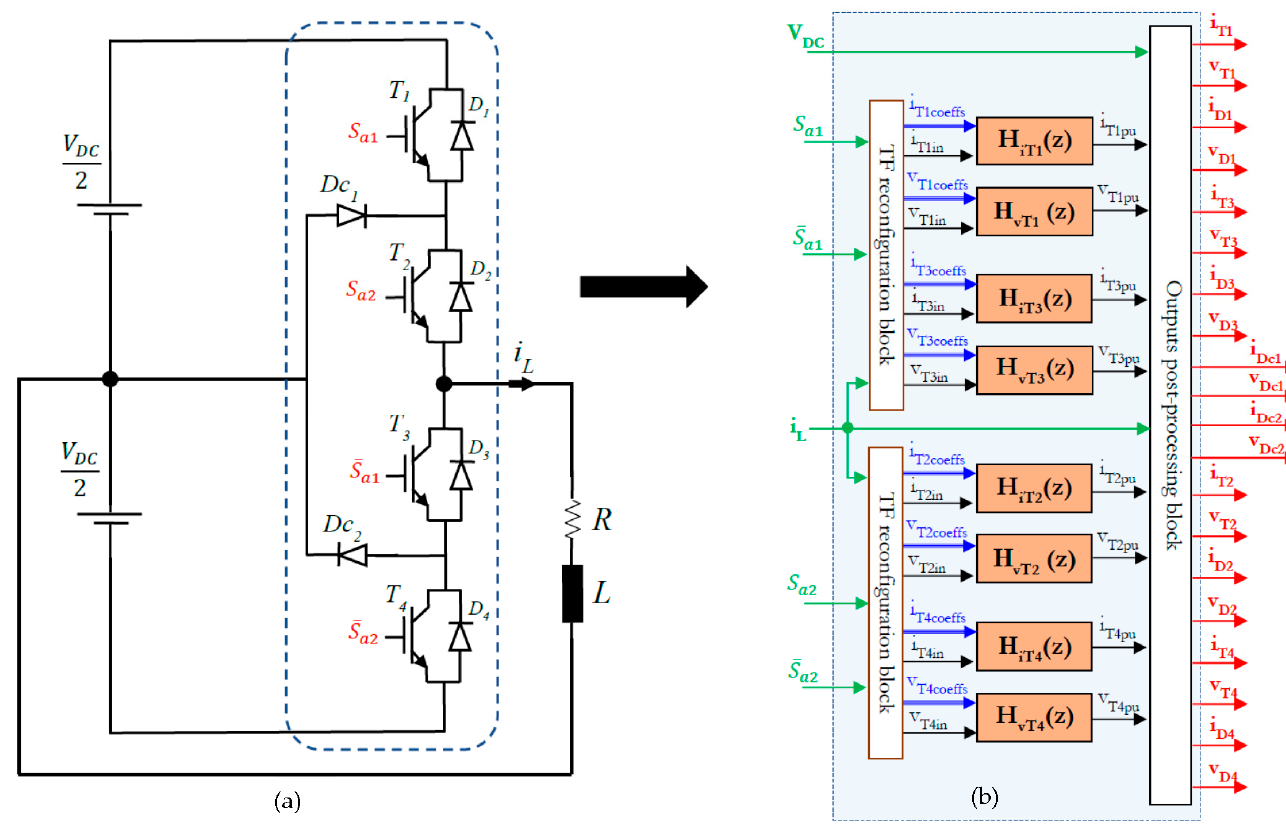
Figure 8. eRTS Half-Bridge NPC inverter. ( a ) topology, ( b ) corresponding eRTS architecture. An open-loop controller id implemented for this case study. A sinusoidal voltage reference od applied with 0.9 pu amplitude (over V DC /2 = 300 V) and 200 Hz frequency. The switching signals ( S a 1 , S a 1 ) and ( S a 2 , S a 2 ) are generated based on two 10 kHz PWM carriers, and the corresponding waveforms are highlighted in Figure 9. In addition, ( S a 1 , S a 1 ) are generated by comparing the voltage reference to the upper PWM carrier and ( S a 2 , S a 2 ) by comparing to the lower one.